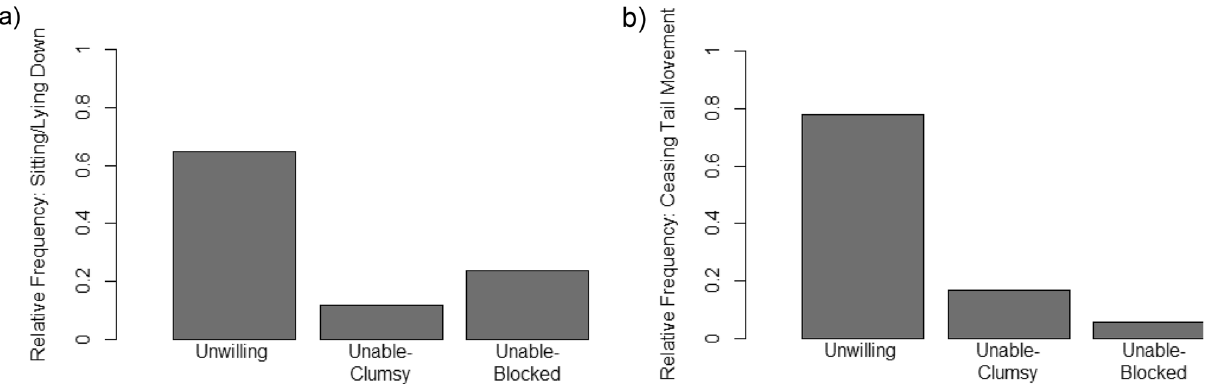
Figure 3. Relative frequencies of behavioural reactions. ( a ) depicts how often dogs sat/lay down relative to the number of overall occurrences of sitting and lying down. Eight dogs sat/lay down only in the unwilling condition, three dogs in the unwilling condition and at least one unable condition, and two dogs did not sit down in the unwilling-condition but only in the clumsy or the blocked condition. ( b ) Depicts the equivalent for ceasing tail movement. Eleven dogs ceased moving their tails only in the unwilling condition, three in the unwilling condition and at least one unable condition, and one dog ceased tail movement only in the clumsy